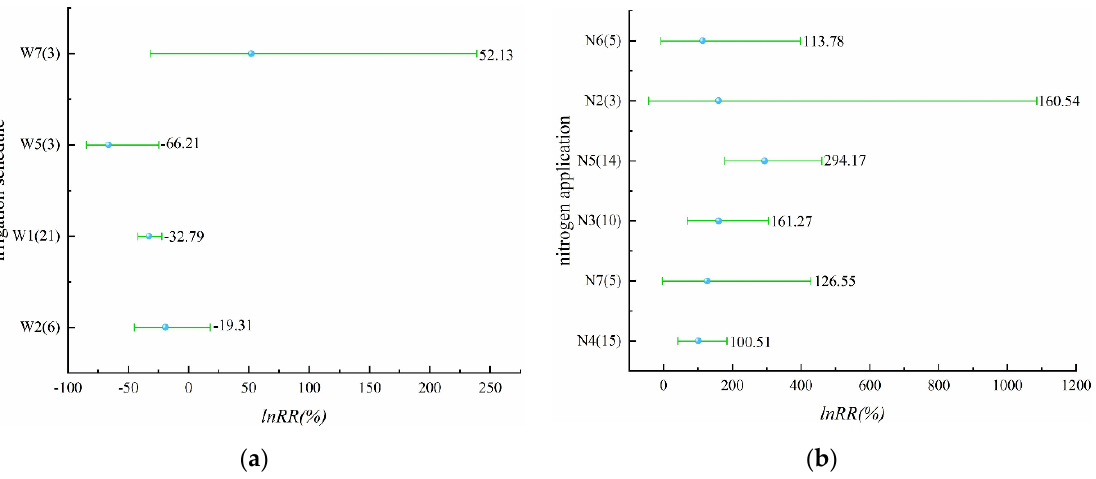
Figure 7. ( a ) Effect of different irrigation schedules on nitrogen runoff ( p = 0.00138); ( b ) effect of different nitrogen application levels on nitrogen runoff ( p = 0.52096).